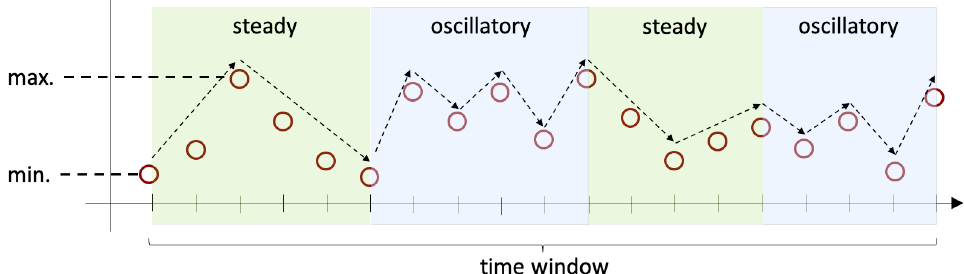
Figure 2. Variation patterns over time.